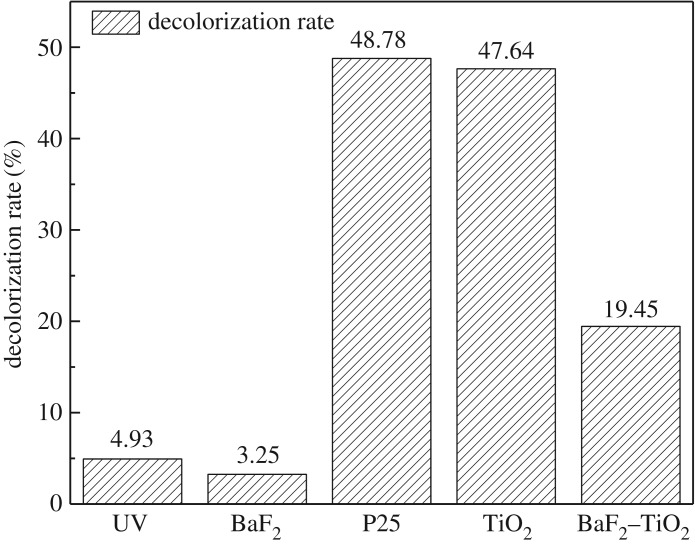
Effect of different catalysts on the decolorization rate of methyl orange solutions irradiated with UV light (CBaF2, CTiO2, CP25: 1 g l−1; C0.35-BaF2–TiO2: 1.35 g l−1).